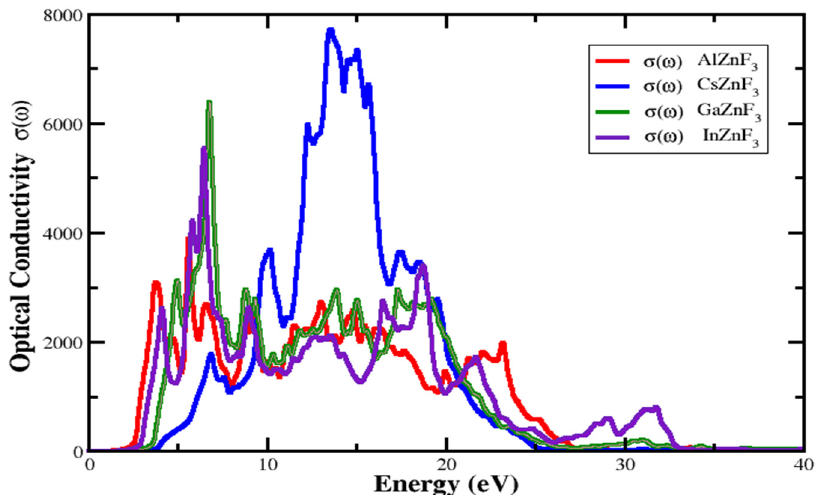
Figure 10. Optical conductivity of XZnF 3 (X = Al, Cs, Ga, In).